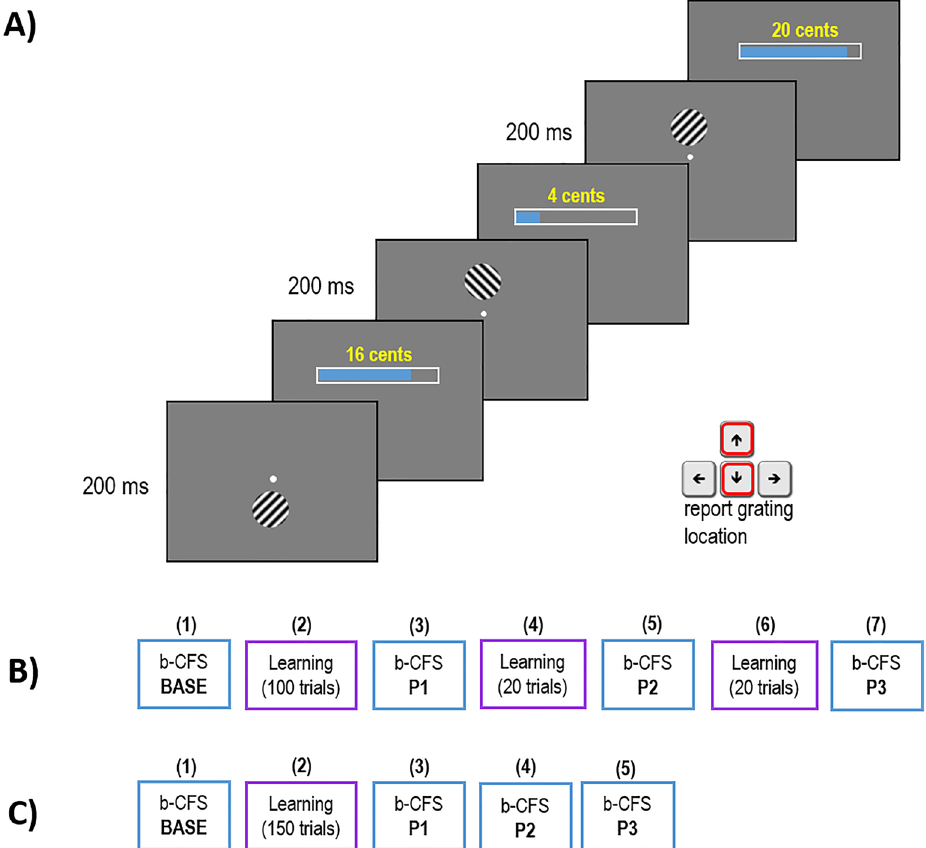
Figure 2. Pavlovian associative learning paradigm and experimental pipeline. ( A ) Associative learning task. Observers learned the association between each of two possible visual orientations and either high or low monetary reward using a Pavlovian conditioning paradigm. ( B ) Experimental pipeline for Experiment 1. ( C ) Experimental pipeline for Experiment 2. BASE = baseline session, P1-P2-P3 = post-learning